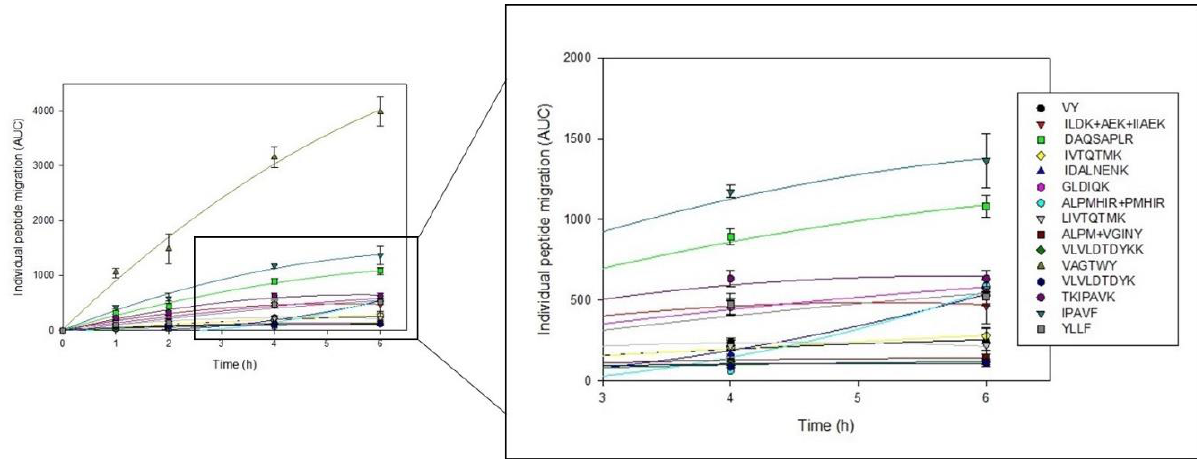
Figure 5. Evolution as a function of time of the individual migration of the major components found in the peptide recovery fraction (LC-UV 214 nm data).